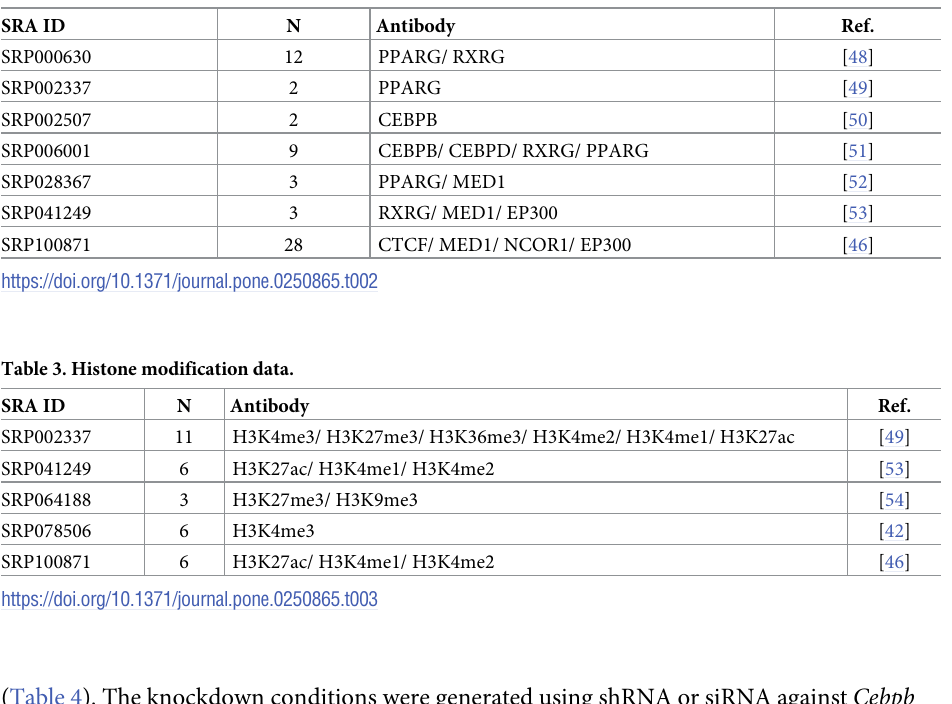
(Table 4). The knockdown conditions were generated using shRNA or siRNA against Cebpb or Pparg respectively, or against scrambled sequences as controls. Gene counts and probe